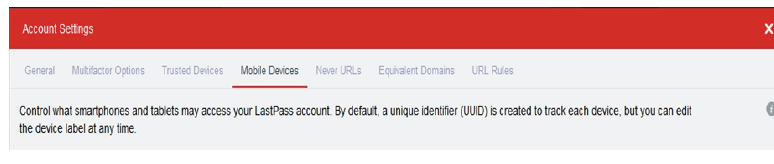
Figure A9. Computer jargon (Account Settings in